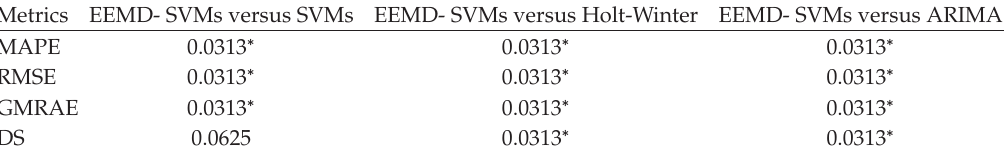
Table 2: Wilcoxon’s signed-rank test for EEMD-SVMs against the three individual models.